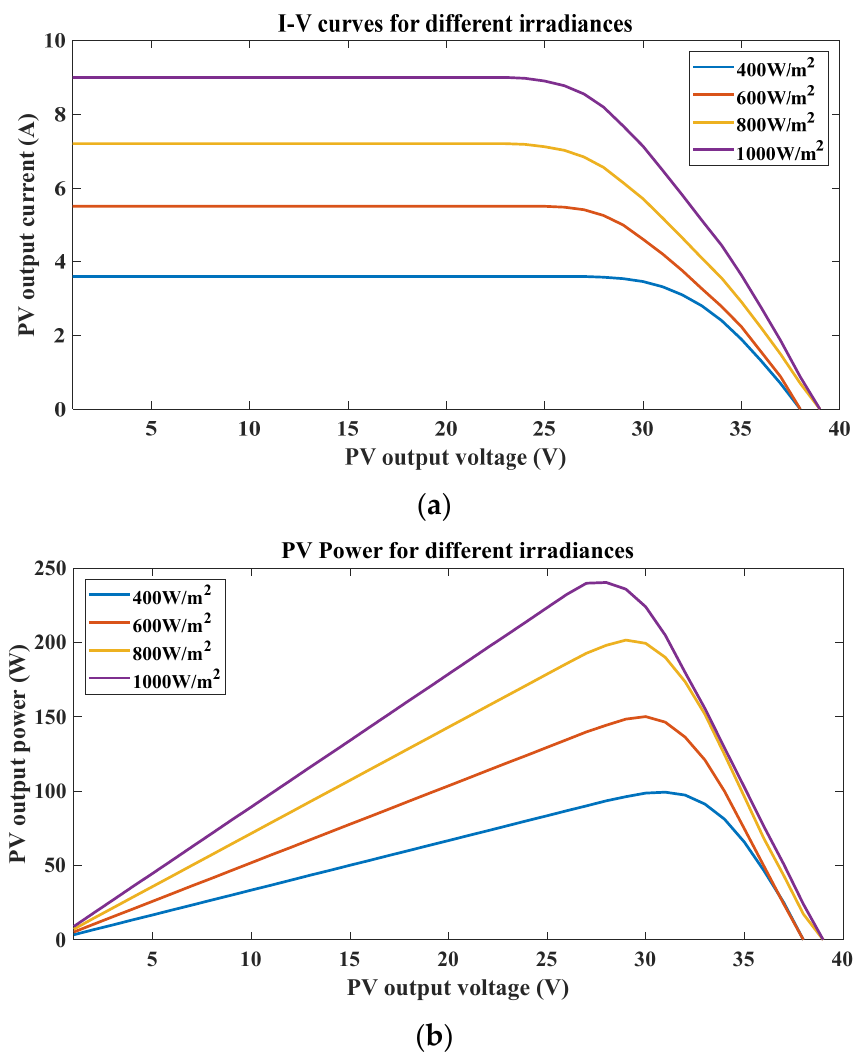
Figure 2. ( a ) I-V curve of ideal PV panel; ( b ) P-V curve of ideal PV panel. The objective of the controller is to keep ∂ P PV / ∂ V PV at or near zero (or to keep ∂ I PV / ∂ V PV equal to − I PV / V PV ). Figure 3 illustrates the control circuitry of the PV system introduced in Figure 1. The PI controller 1 is tuned to keep ∂ P PV / ∂ V PV near zero and